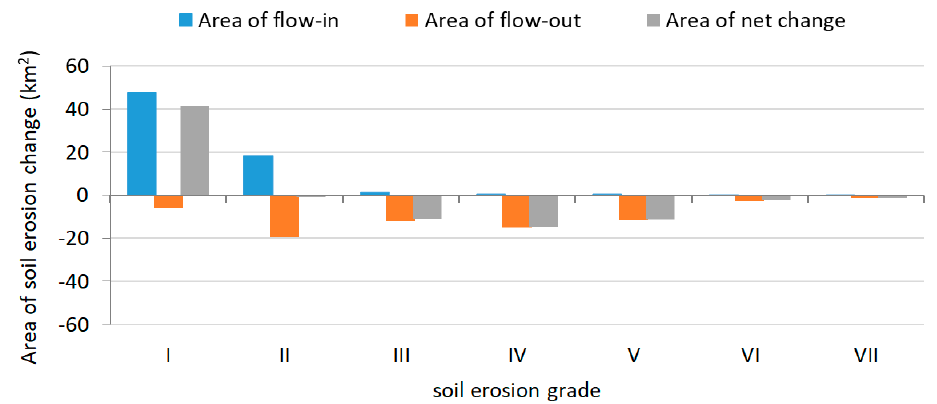
Figure 3. Area change in a different grade from 1977 to 2015 (the area of flow-in represents the area of change from 1977 to 2015, the area of flow-out refers to the opposite conversation and the area of net change was the total area change from 1977 to 2015).